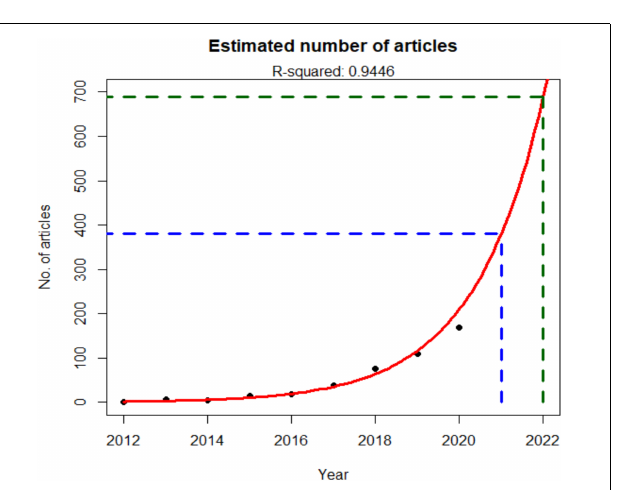
TABLE 3 | Number of publications of the most productive